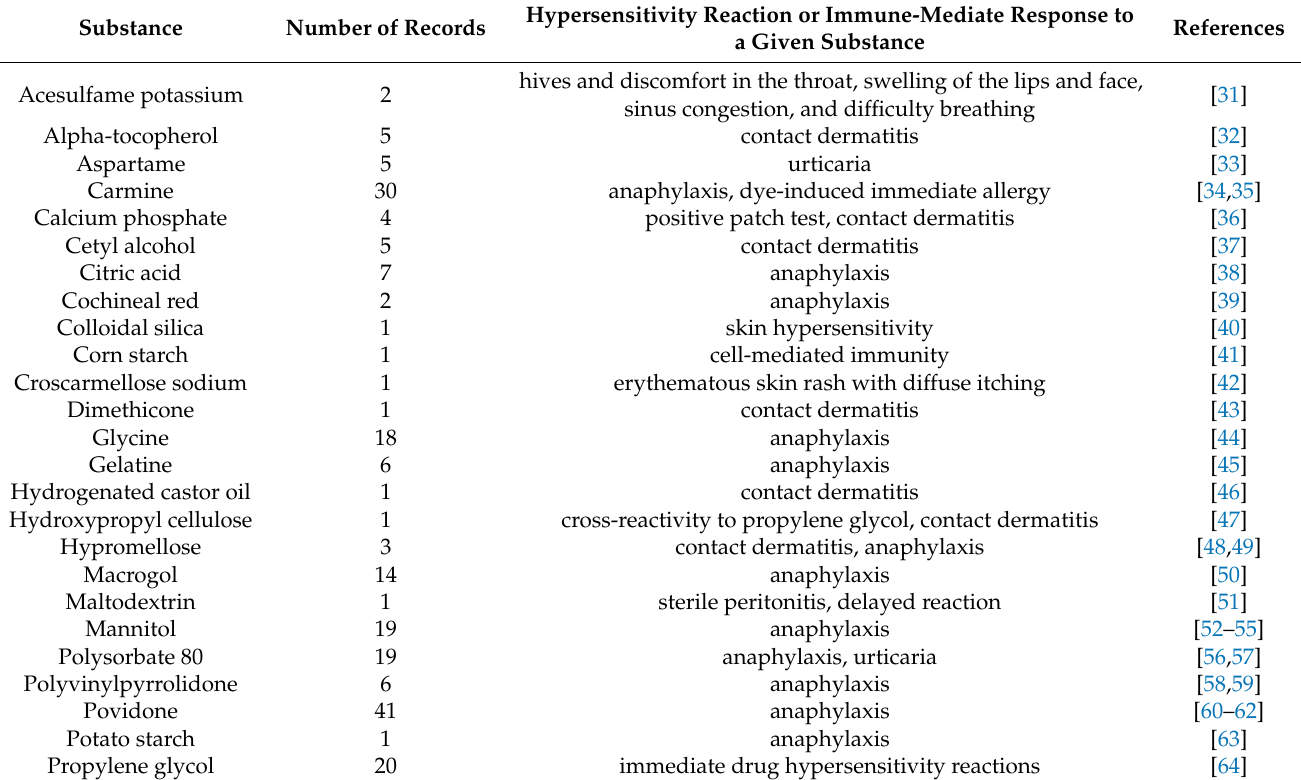
Table 4. Excipients for which the search revealed data on hypersensitivity reactions or immune responses related to them, together with the number of recorded